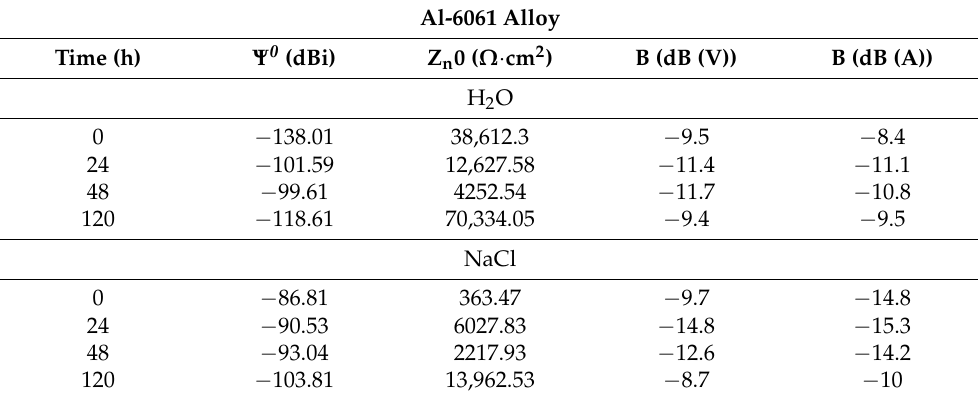
Table 5. Parameters obtained by PSD for the Al-6061 alloy.